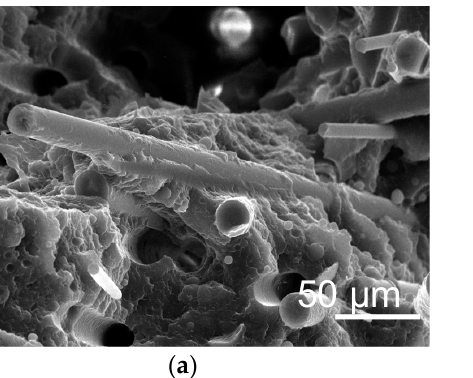
Figure 10. Comparison of wet-out with ( a ) 66% recycled and ( b ) 100% recycled content material.